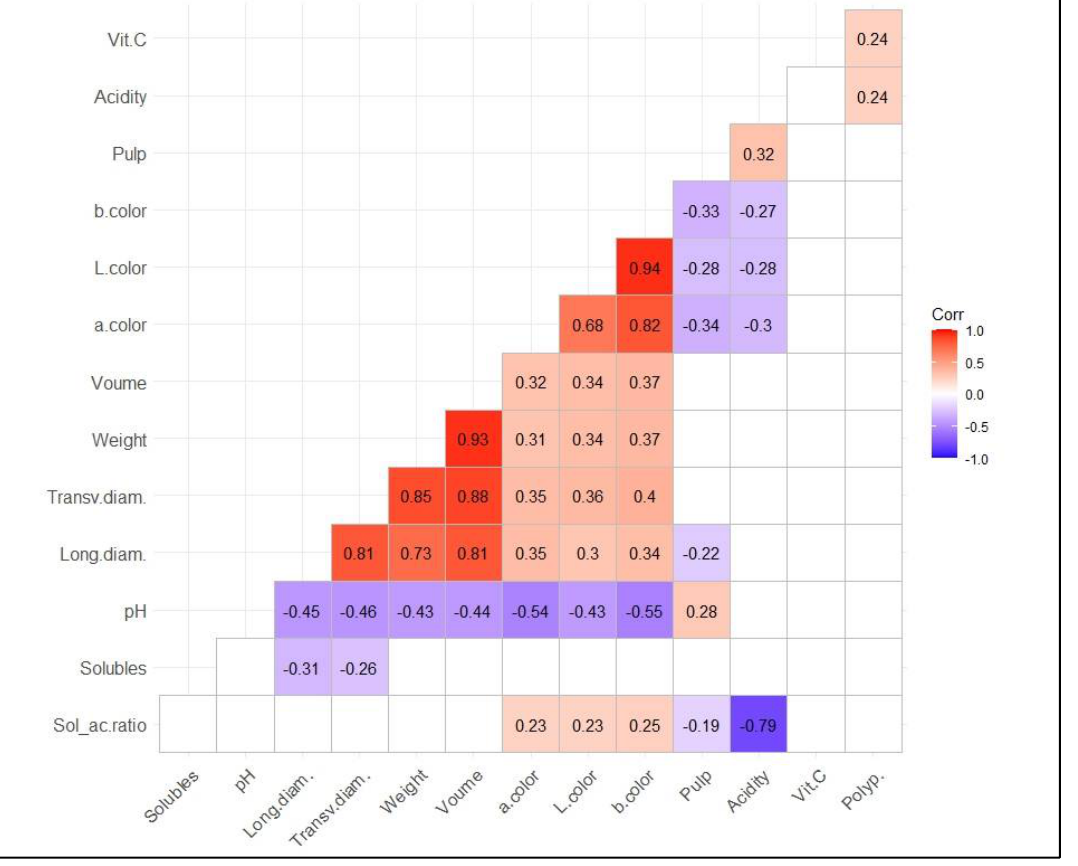
Figure 5. Heat map correlation matrix representing correlations (Pearson coefficients) among the biochemical and morphological variables. The values of correlation reported in the heat map resulted significantly different per p < 0.05.